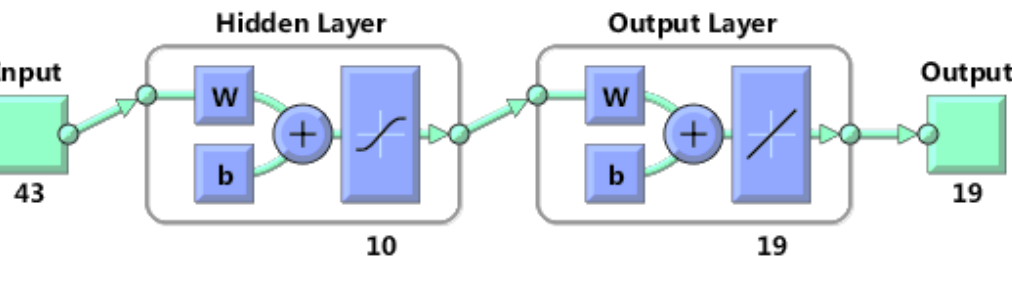
Figure 4. Setup of the neural